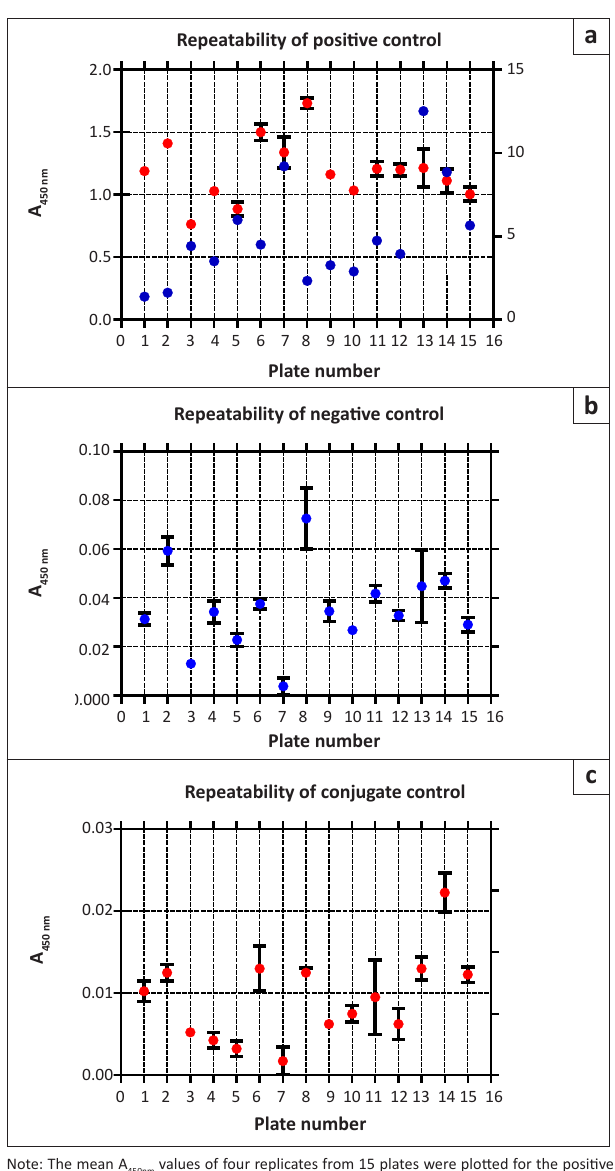
values were plotted against the left Y-axis and the per cent coefficient of variance ( % CV) nm against the right Y-axis. The standard deviation is presented in black. FIGURE 2: Repeatability of the double-antigen ELISA when tested with the control sera for (a) the positive control, (b) negative control and (c) conjugate control.